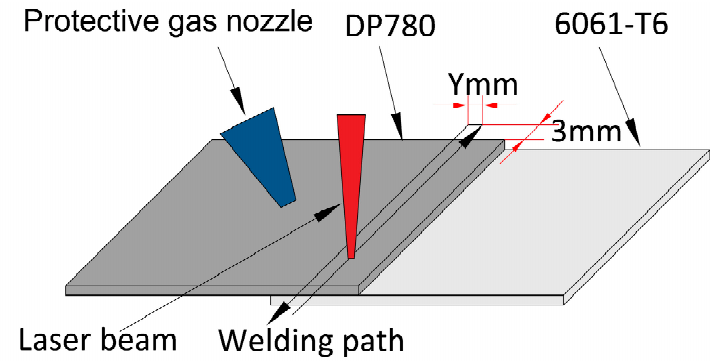
Figure 2. In the weld seam area, the model is divided by a 0.1 mm free tetrahedral mesh, and the time-step was 0.003 s. The ambient temperature in the model is 300